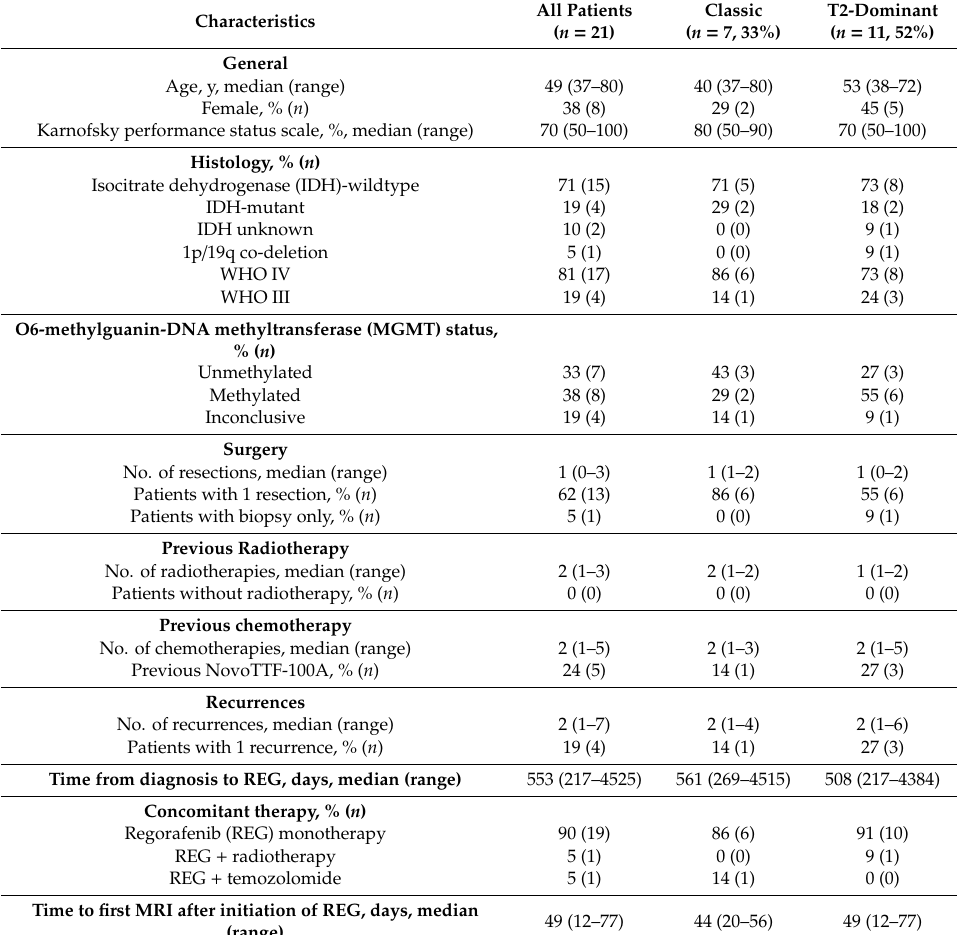
Table 1. Patient characteristics, previous treatments, concomitant therapy, and magnetic resonance imaging (MRI)